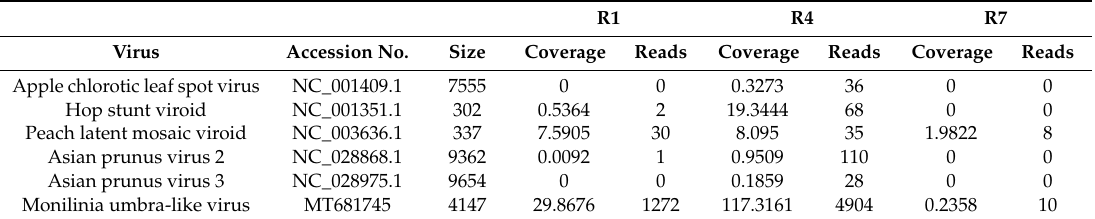
Table 1. Summary of identified plant viruses, viroids, and mycoviruses from three RNA libraries. R1 R4 R7 Virus Accession No. Size Coverage Reads Coverage Reads Coverage